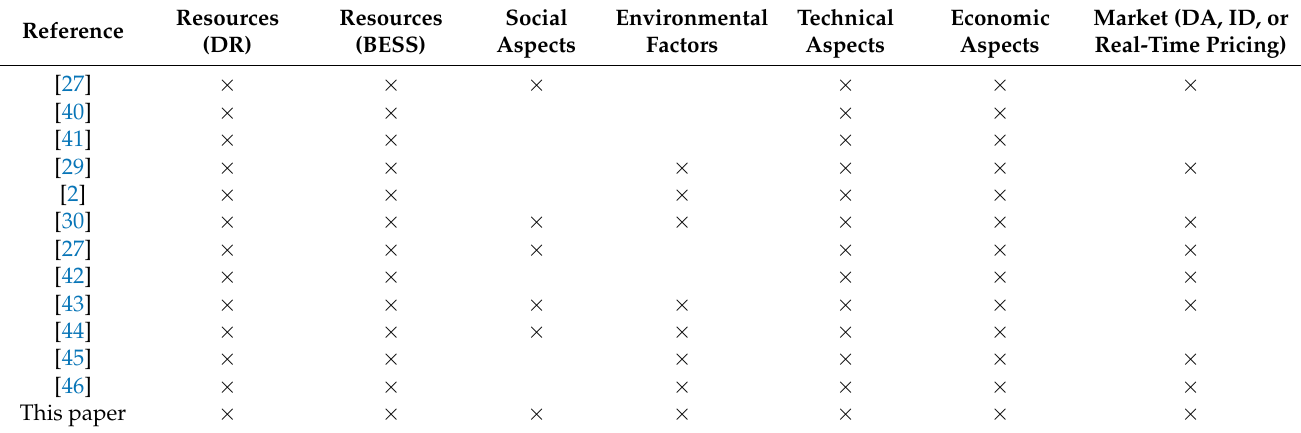
Table 2. Taxonomy of Recent